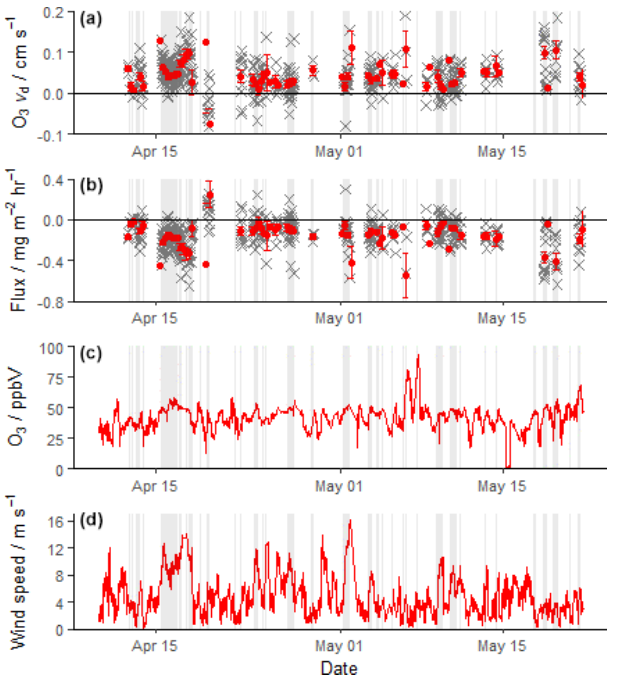
Figure 7. Time series of ozone deposition velocity (a) , ozone mass flux (b) , mean ozone concentration (c) , and mean wind speed (d) from 10 April to 21 May 2018. Grey crosses represent 20min val- ues, with red dots for 6h means with standard errors. All concen- tration and wind speed data are shown from 10 April to 21 May, with only deposition/flux values that passed filtering criteria shown in panels (a) and (b) . Periods with an accepted wind direction (180–240 ◦ ) are shaded. Flux and deposition velocity data are thus only presented from these periods and when the wind speed was > 3ms − 1 (d) . The y axis in panels (a) and (b) is limited to − 0.1– 0.2cms − 1 and − 0.8–0.4mgm − 2 h − 1 respectively for clarity.